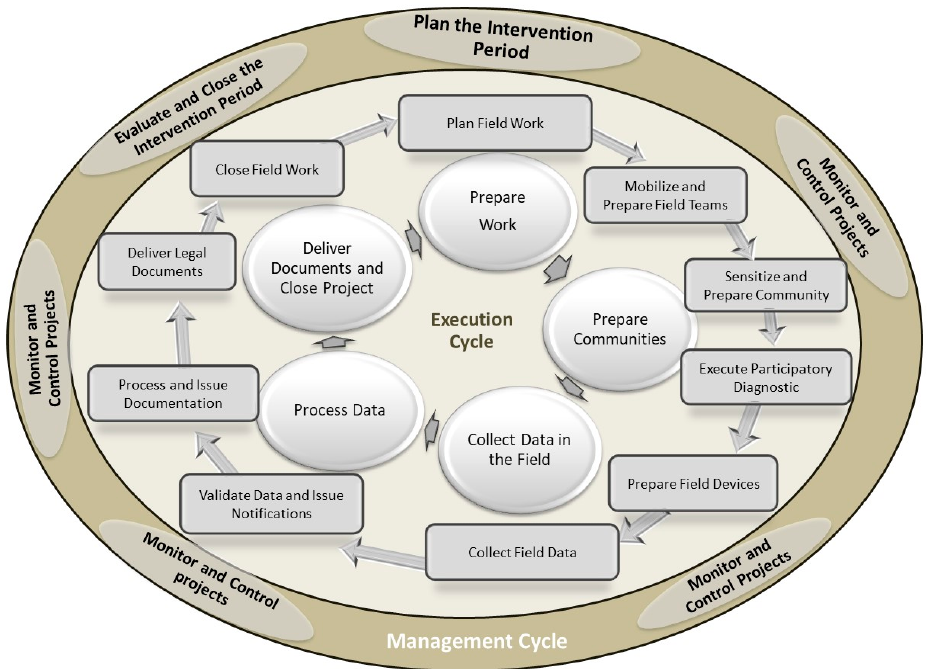
Figure 9. The processes of the FFPLA-MOZ approach. Outer ring: Managerial processes (Plan, Monitor and Control, and Evaluate and Close). Inner ring: Execution processes (Prepare the Field Work, Prepare Communities; Collect Data in the Field, Process Data, Deliver Documents and Close Project). Source: Developed from [37].